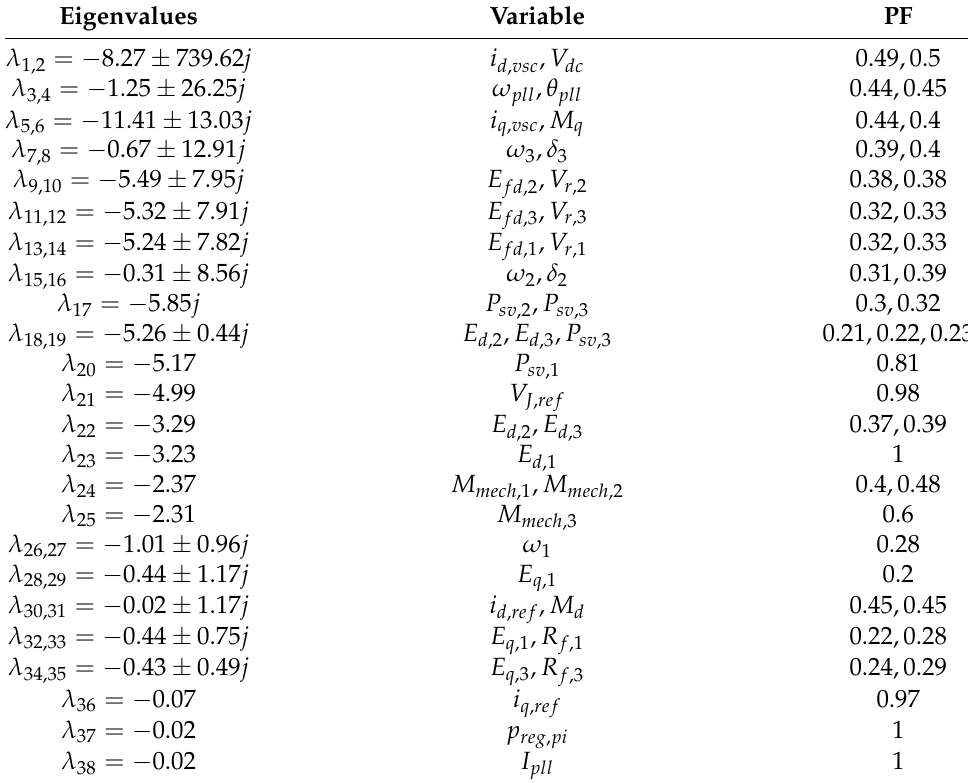
Table 3. The eigenvalues and participation factors of the system with ROCOF